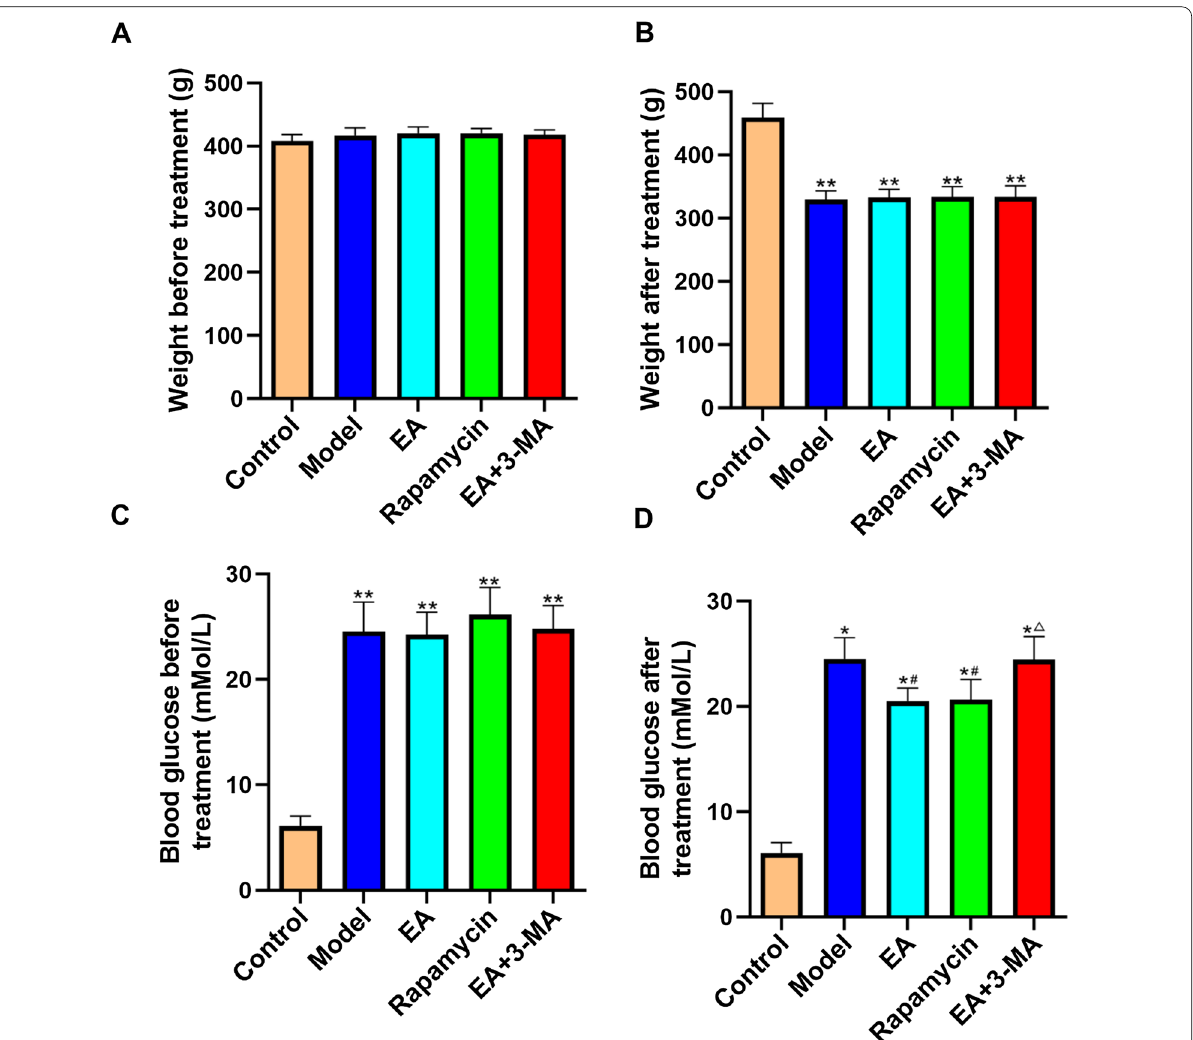
Fig. 2 Effect of EA on body weight and blood sugar in diabetic rats. a Weight before treatment, b weight after treatment, c blood glucose before treatment, d blood glucose after treatment. Data are expressed as mean versus control group; # p < 0.05 versus model group; △ p < 0.05 versus EA